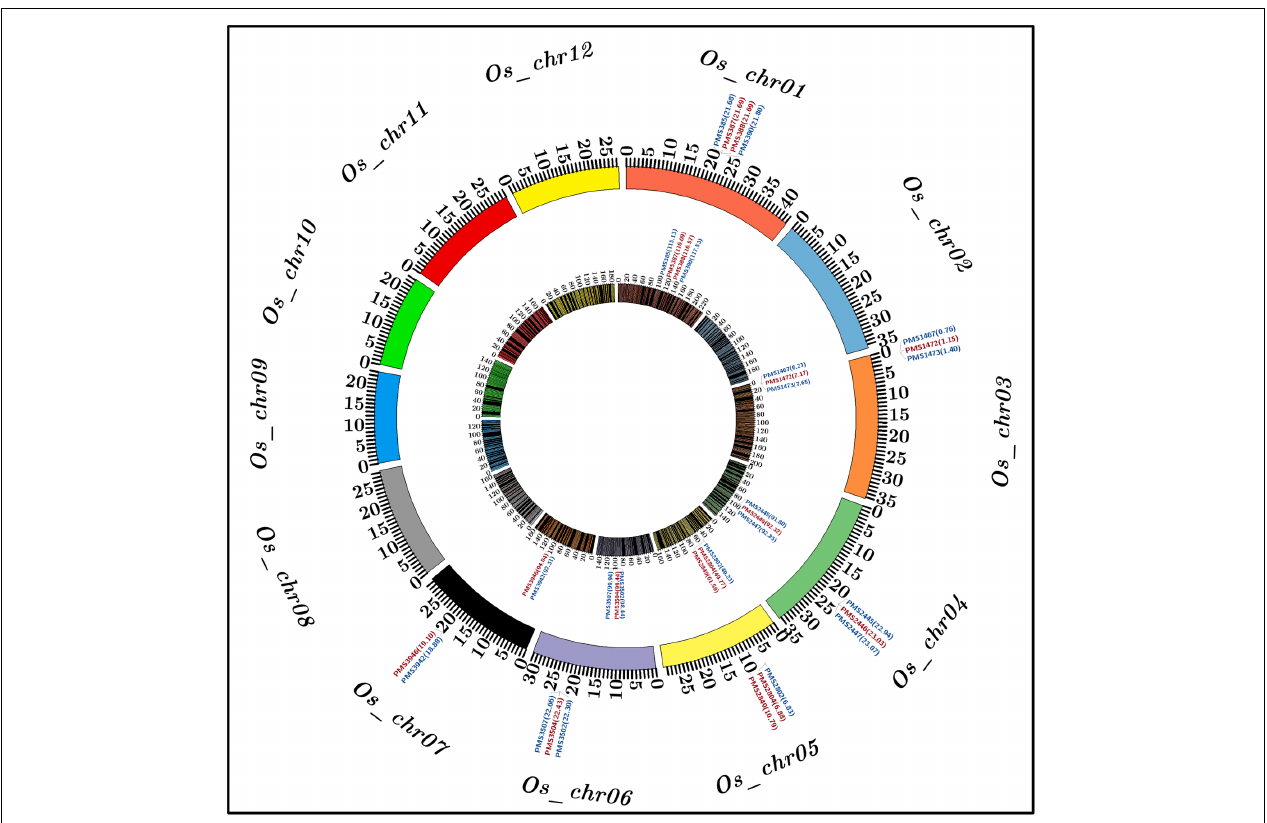
FIGURE 2 | Molecular mapping of six major grain weight quantitative trait loci (QTLs) on a high-density genetic linkage map (IR 64 × Sonasal) generated by anchoring 3791 genome- and known cloned/candidate genes (TFs)-derived in silico polymorphic SSR markers on 12 rice chromosomes, which is depicted by a Circos circular ideogram. The constructed high-resolution genetic map identified seven SSR markers-containing candidate genes at six major genomic regions harboring grain weight QTLs mapped on six rice chromosomes 1, 3, 4, 5, 6, and 7. The SSR markers flanking and tightly linked to the major grain weight QTLs are highlighted with blue and red color, respectively. The inner circle designates the diverse genetic map-length (cM) (spanning 5 cM uniform genetic distance intervals between bins) of 12 linkage groups/chromosomes coded with multiple colors. The outer circle denotes the various physical sizes (Mb) of 12 chromosomes coded with multiple colors as per the pseudomolecule sizes documented by MSU rice genome annotation project release 7.0. The digits mentioned within the parentheses of inner and outer circles denote genetic (cM) and physical (bp) positions of mapped SSR markers flanking/linked to the major grain weight QTLs, respectively, in rice. The detail information regarding SSR markers are provided in the Supplementary Table